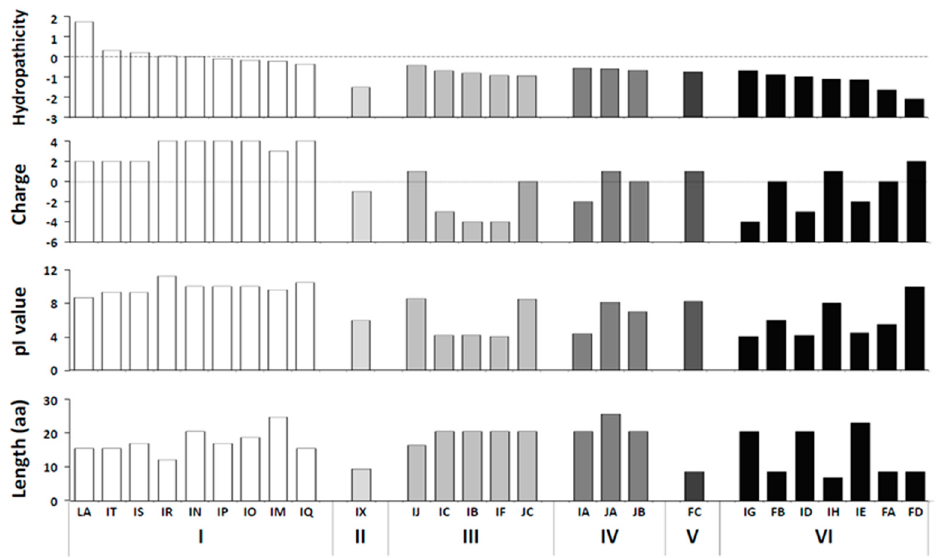
Figure 2. The effect amino acid physicochemical parameters of the heterologous peptide on chimeric virus accumulation. The bars show the hydropathicity, charged, pI value and length grand averages for foreign peptide encoded by each construct. Chimeric BaMV accumulation in C. quinoa was normalized using BS-d35CP (100%) to account for chimeras; group I: 0%, II: 1–20%, III: 21–40%, IV: 41–60%, V: 61–80%, VI: 81–100%. Group I, II, III, IV, V, and VI are distinguished using white to black shadings.